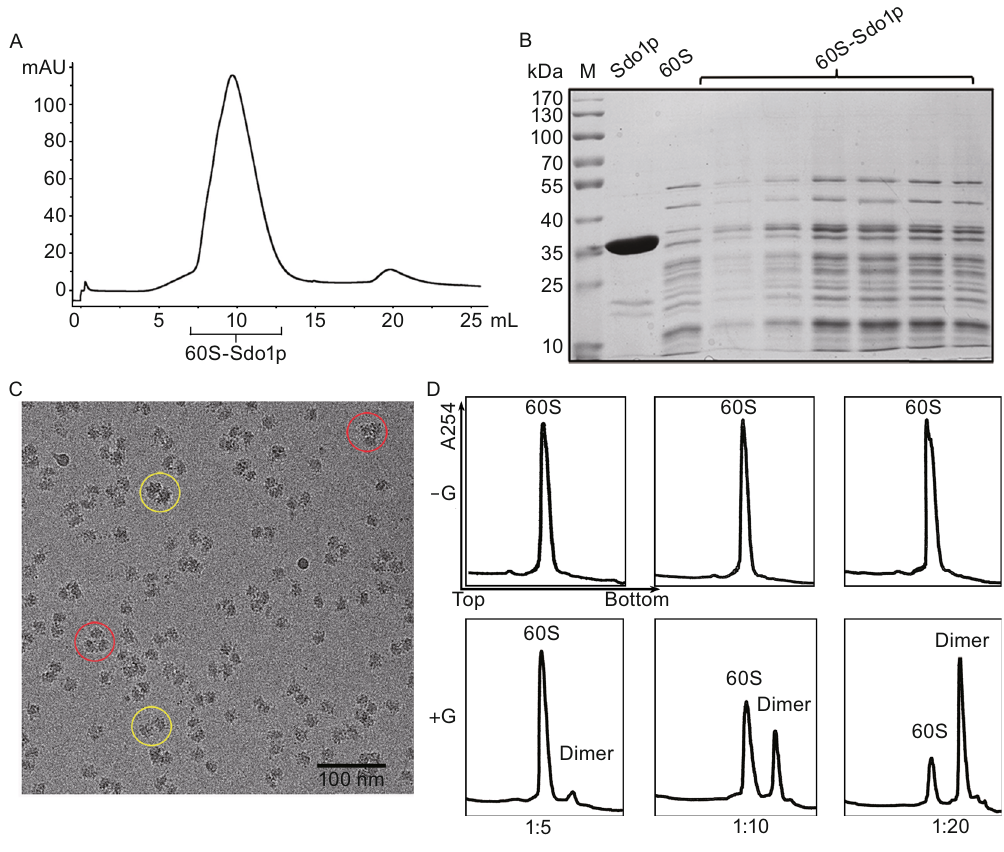
Figure 1. Sdo1p binds to the mature 60S subunit in vitro . (A) Gel fi ltration trace of the 60S-Sdo1p complex monitored by UV absorption at 280 nm. (B) SDS-PAGE examination of fractions labelled in (A). M, maker lane; Sdo1p, loading input containing Sdo1p only; 60S, loading input containing 60S only. (C) A representative cryo-EM micrograph of the 60S-Sdo1p complex (without crosslinking). Particles of 60S dimers and trimers are highlighted by yellow and red circles, respectively. (D) Examination of the formation of 60S dimers by Sdo1p using sucrose density gradient centrifugation. 5-, 10- or 20-fold excess of Sdo1p was incubated with the 60S subunit in the absence ( − G) or presence (+G) of